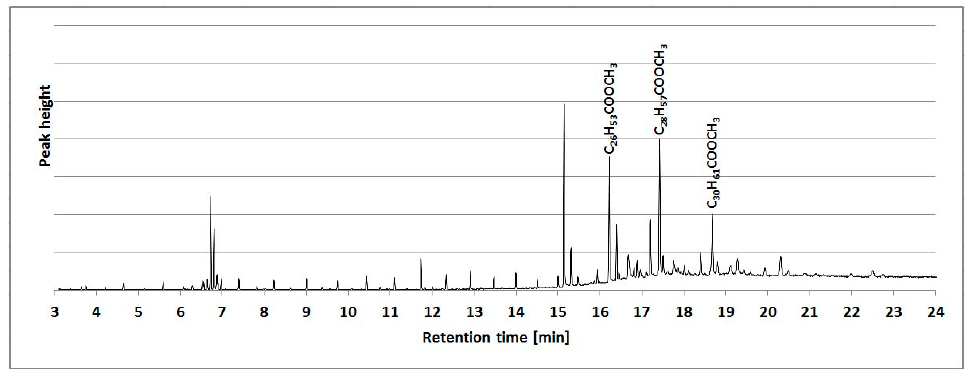
Figure 3. GC-MS chromatogram of product obtained by C30+ olefin oxidation with O 2 (Table 8, Entry 3; mass spectra Figures S9–S12).